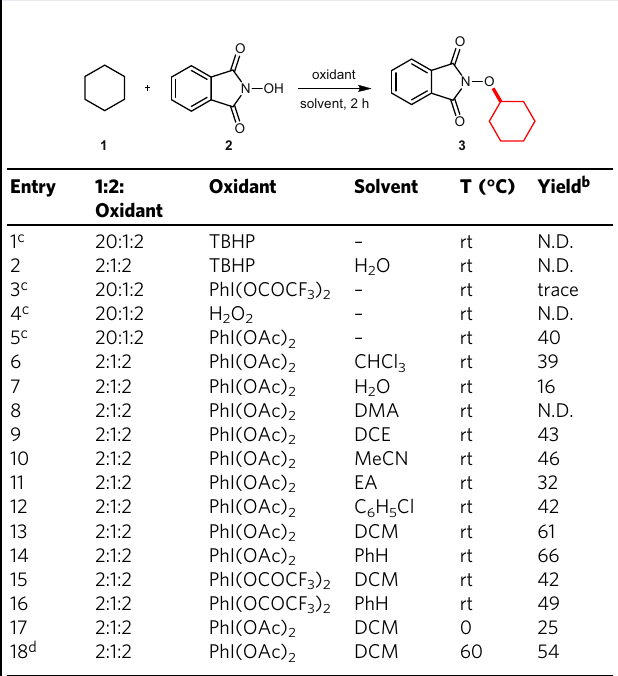
a General procedure: the reaction was carried out with NHPI (1mmol), cyclohexane (2mmol), oxidant (2mmol), and solvent (2mL) at room temperature for 2h. b Isolated yield. c Cyclohexane (20mmol) was used as the substrate and solvent. d The reaction was conducted in re fl